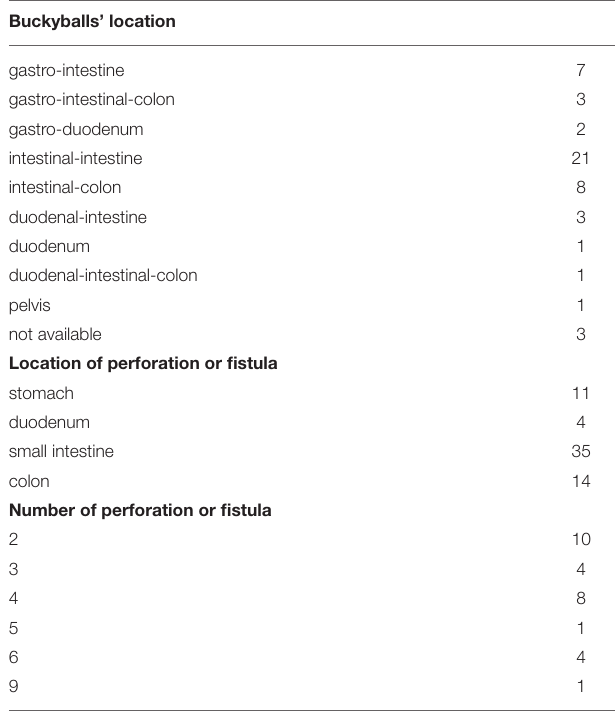
TABLE 1 | A summary of the location of Buckyballs and perforations or